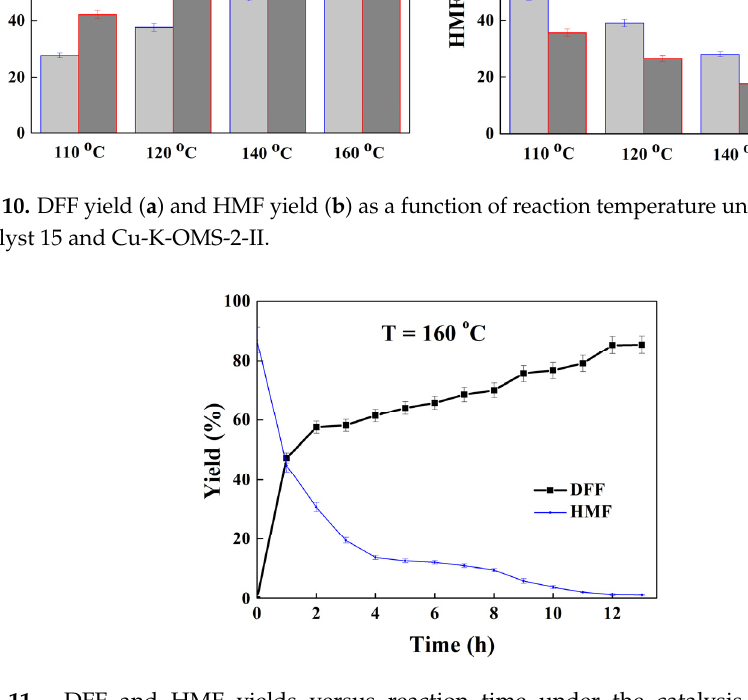
Figure 11. DFF and HMF yields versus reaction time under the catalysis of Amberlyst 15 and Cu-K-OMS-2-II.